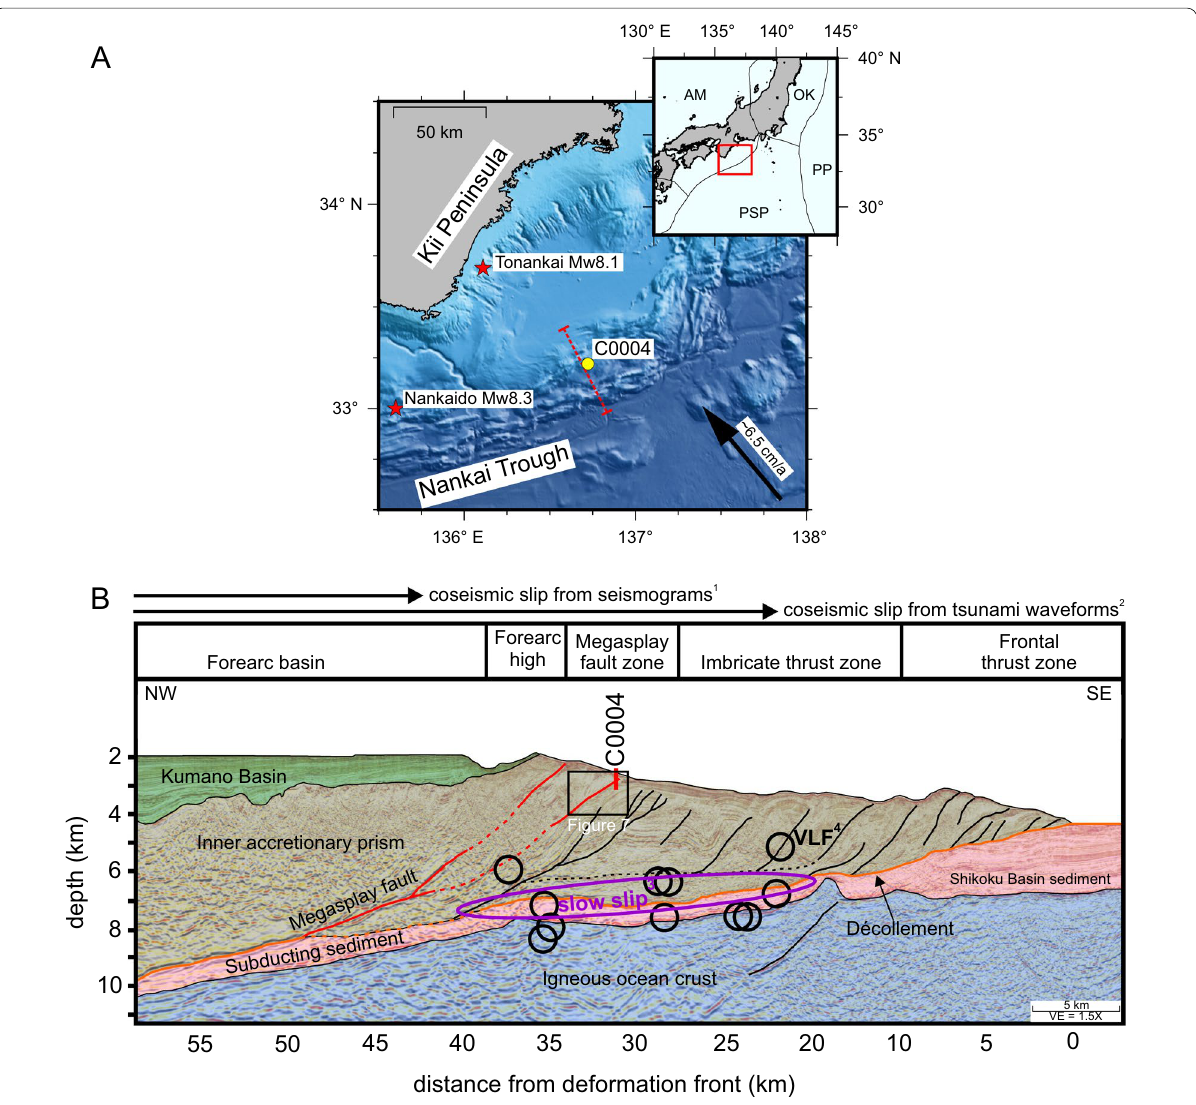
Fig. 1 Nankai Trough bathymetry and seismic cross section. A Bathymetric map (Olson et al. 2016) of the Nankai Trough area indicating drilling Site C0004 and the seismic cross section (red dashed line) shown in B . Megathrust earthquakes from the last century are shown as red stars. PSP: Philippine Sea Plate; PP: Pacific Plate; OK: Okhotsk Plate; Am: Amurian Plate. B The seismic cross section after Moore et al. (2009), showing the extent of coseismic slip of the Tonankai megathrust earthquake ( 1 Kikuchi et al. (2003) and 2 Tanioka and Satake (2001)) as well as slow slip areas ( 3 Araki et al. (2017)) and very low frequency earthquakes (VLF) ( 4 Sugioka et al.